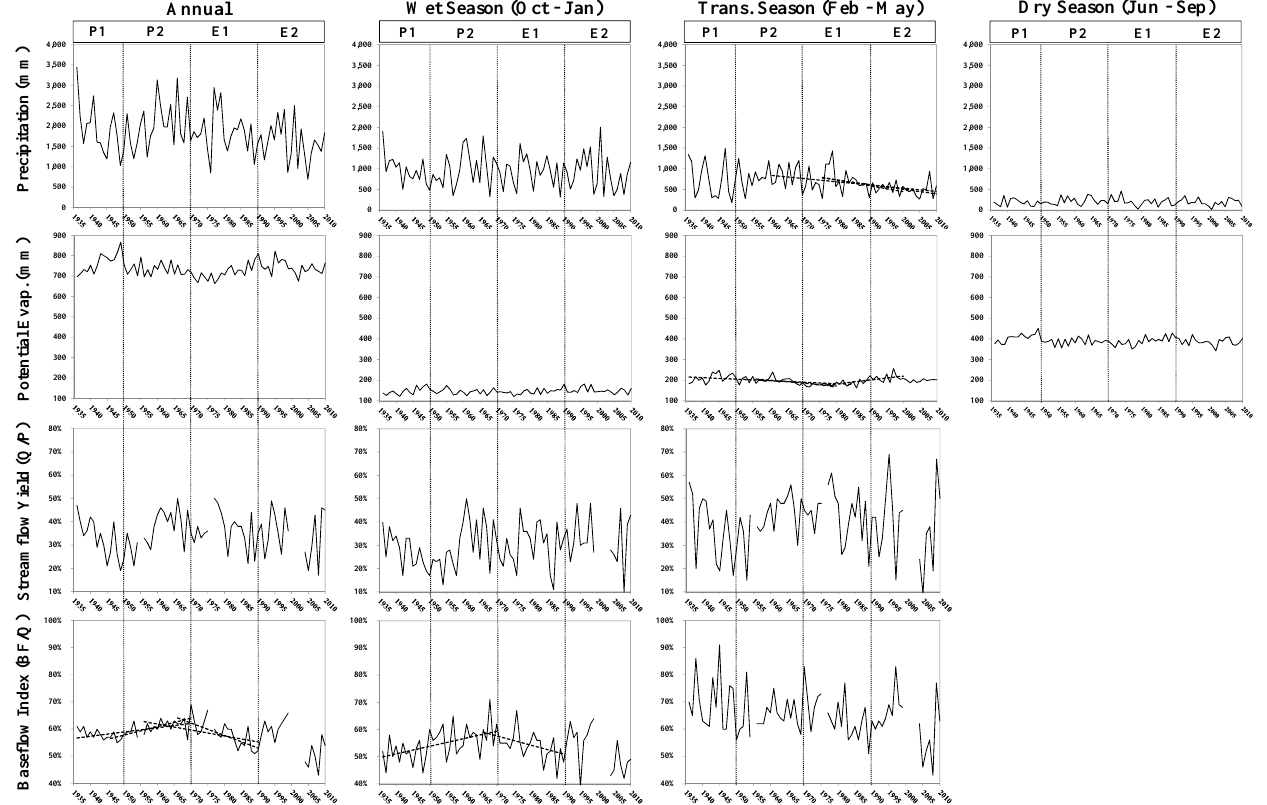
Figure 7. Summary of the trend-testing results, with the afforestation periods (P1, P2, E1, E2; cf. Table 1) overlain for comparison. Significant trends are indicated with dashes